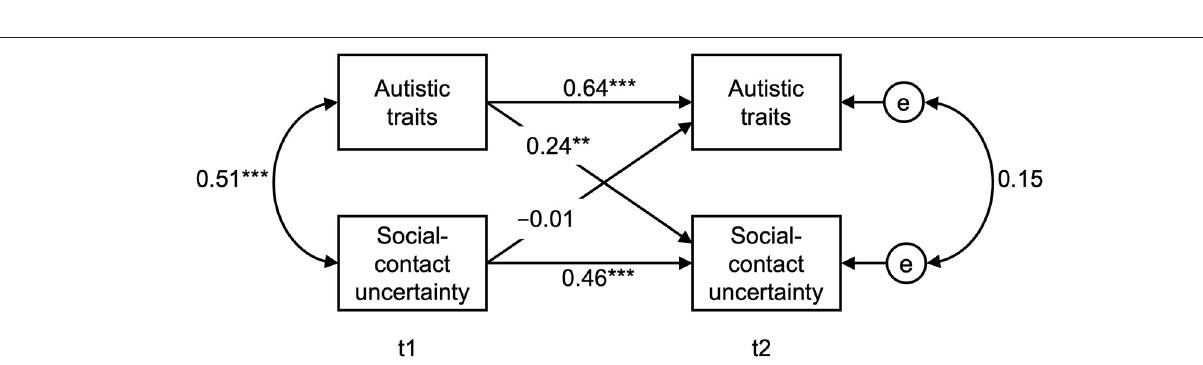
Frontiers in Psychiatry |